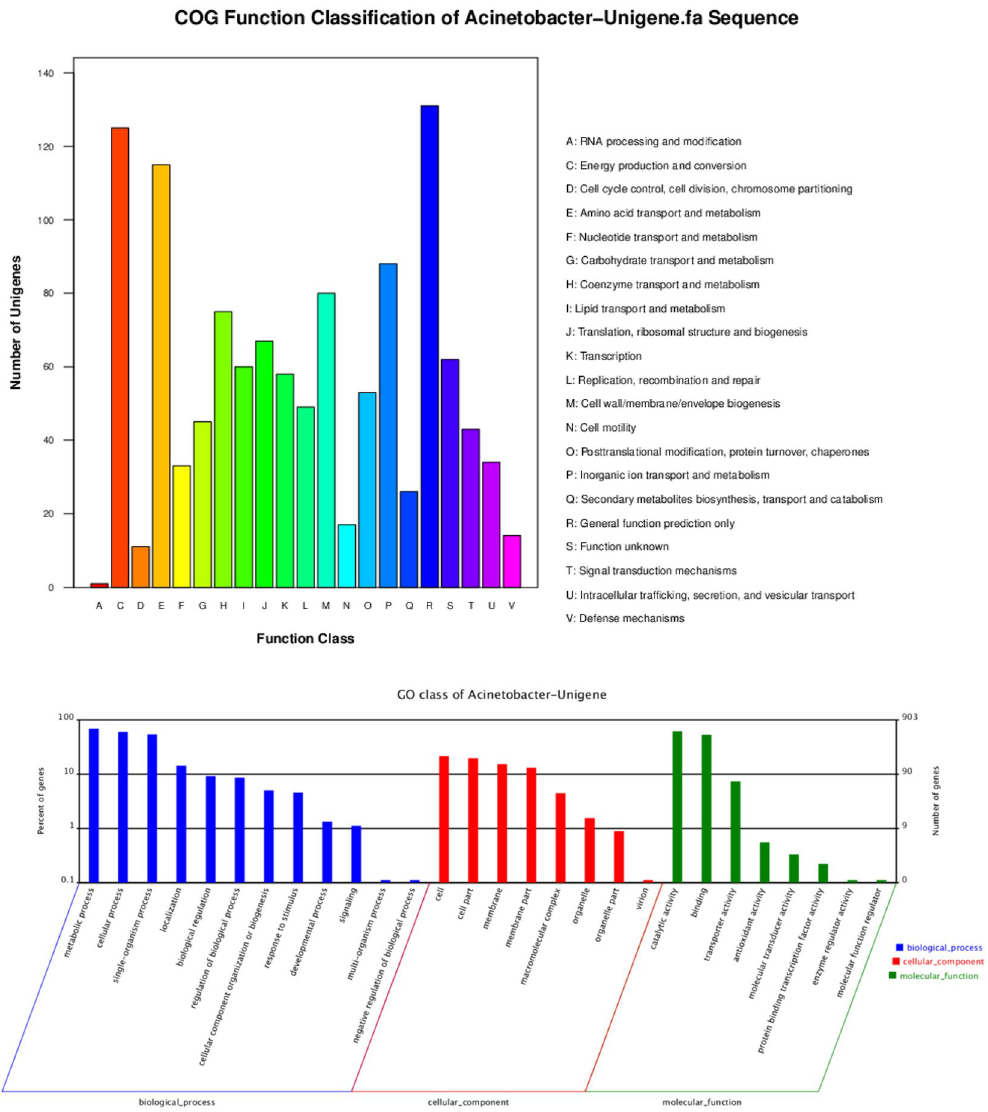
Figure 7. GO and COG function classifications of the unigenes of CK and T